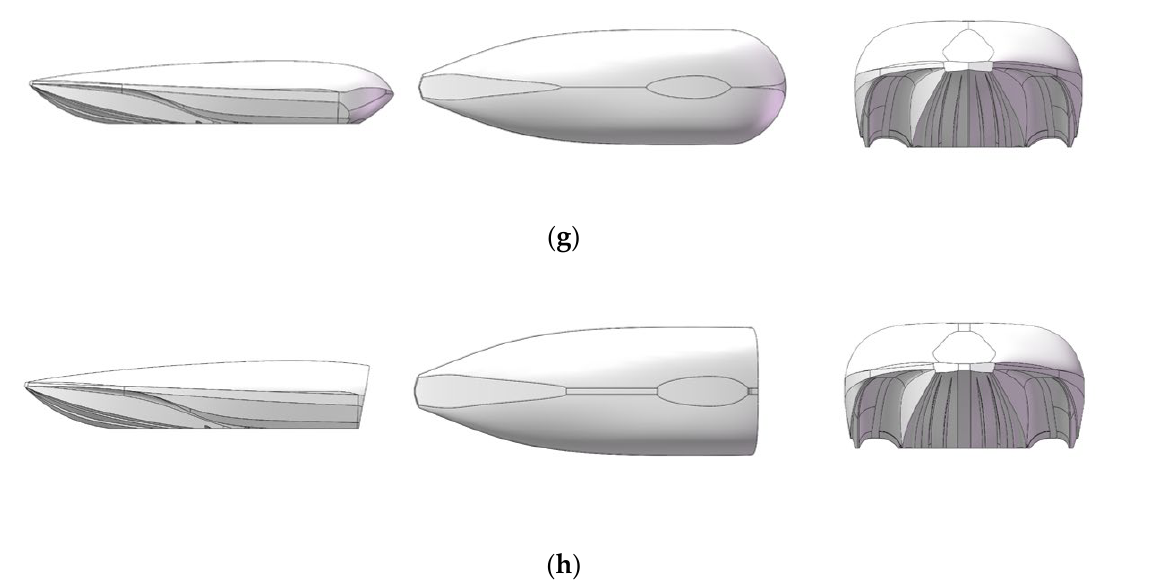
Figure 3. Three views of 8 models: ( a ) Model A01; ( b ) Model A02; ( c ) Model B01; ( d ) Model B02; ( e ) Model C01; ( f ) Model C02; ( g ) Model D01; and ( h ) Model D02.